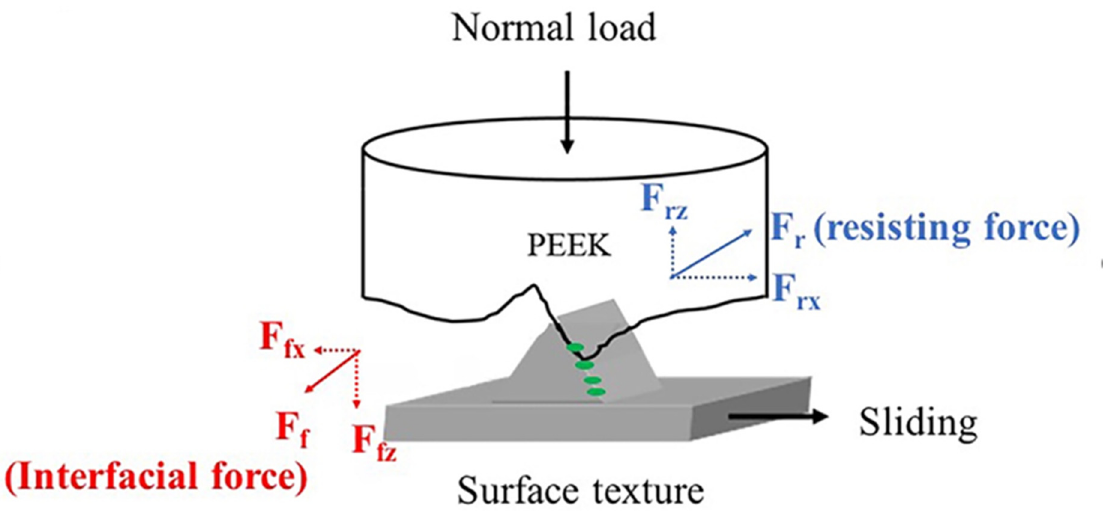
Figure 4. Mechanical analysis of the resisting force and interfacial friction for the surface feature sliding over PEEK process. F rz is upward direction of the resisting force; F rx is horizontal direction of the resisting force; F fz means downward direction of the interfacial friction; F fx is horizontal direction of the interfacial friction. Green circles represent the testing components such as HSA, IgG, or DPPC.